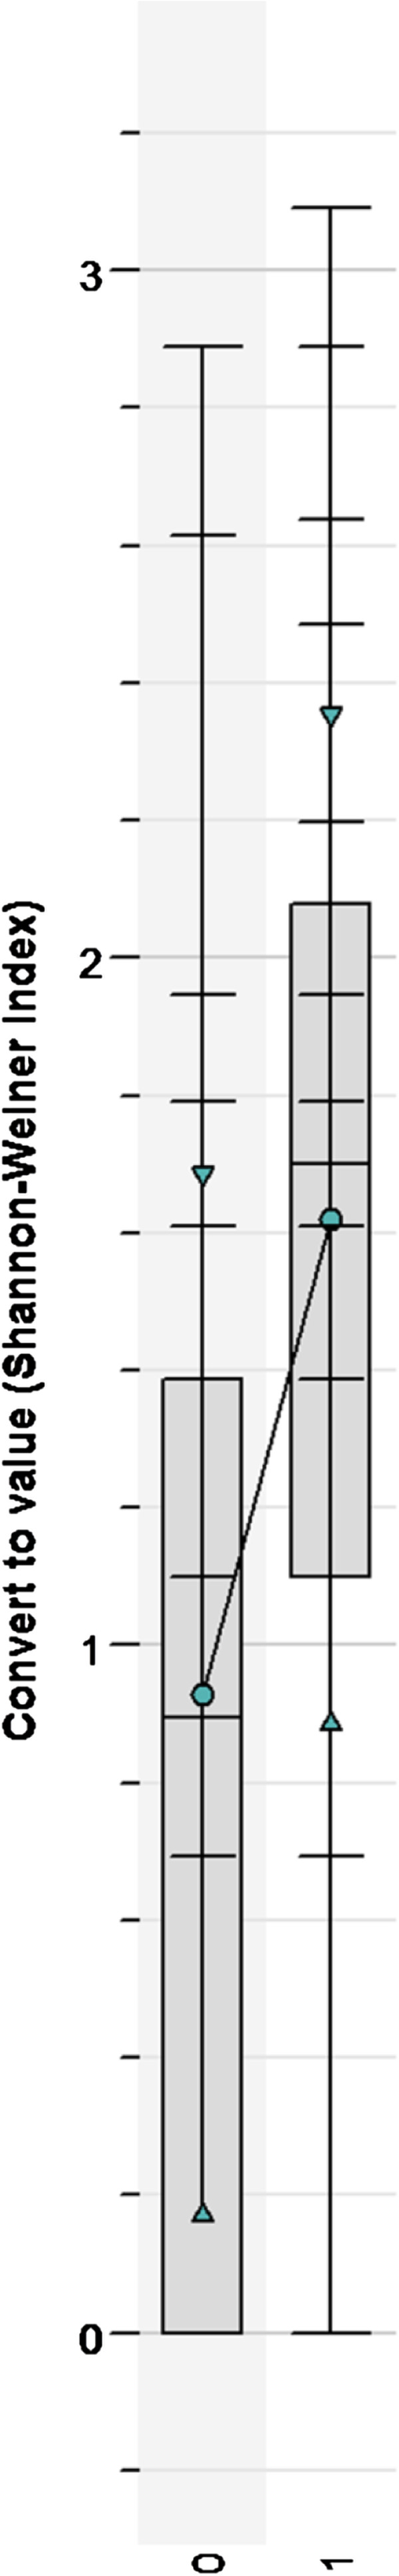
Mann–Whitney U test of the Shannon-Weiner diversity indices from HPV-negative women and HPV-positive women.